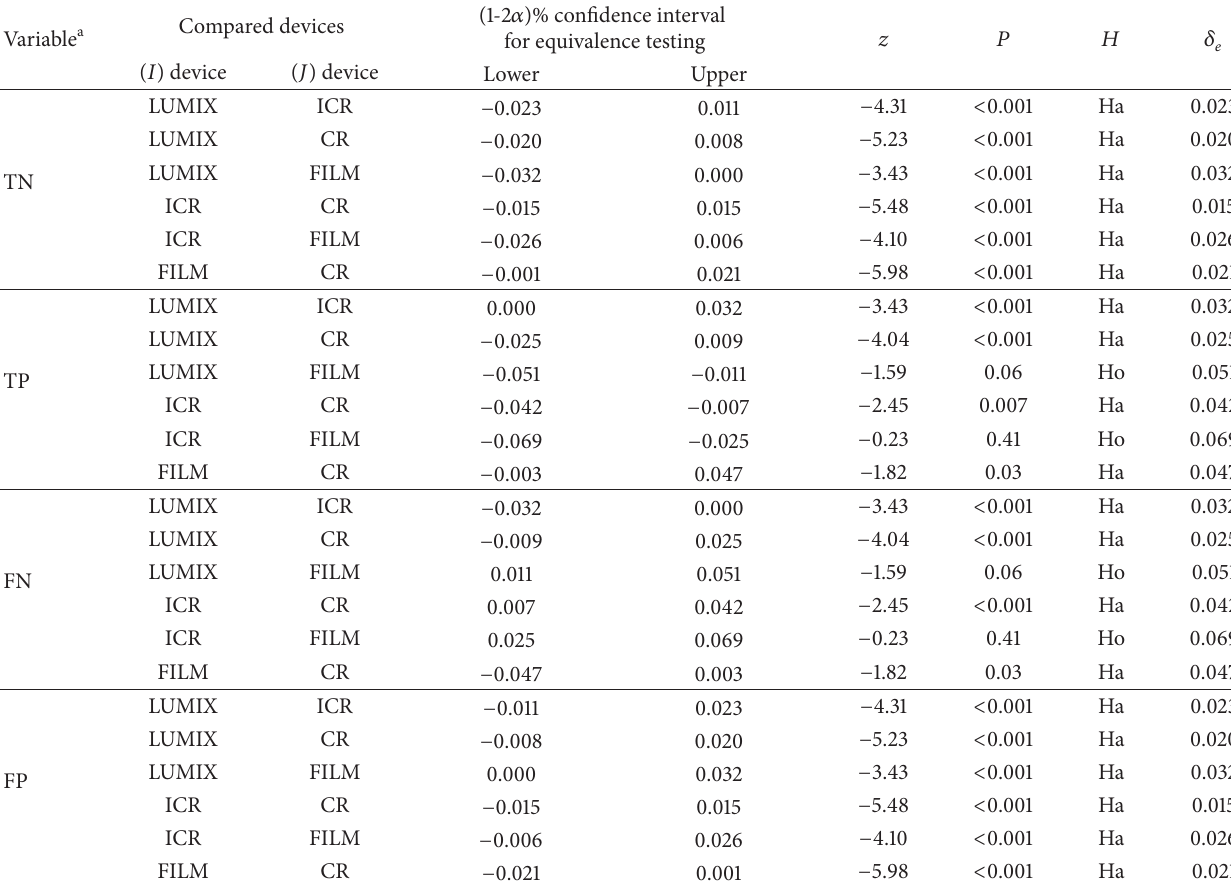
a Each comparison was calculated from 980 observations (70 cases, seven radiologists, and two devices). TN: true negative proportion, TP: true positive proportion, FN: false negative proportion, FP: false positive proportion, SE: standard error of the mean, Ho: null hypothesis, Ha: alternative hypothesis for testing equivalence, 𝛼 : significance of the test (0.05), 𝛿 : difference of the means allowed to achieve equivalence, 𝑧 : test for difference of compared devices, that is, 𝑧 = ( | Difference ( 𝐼 − 𝐽 ) | − 𝛿 )/SE, 𝐻 : retained hypothesis equivalence at 𝛿 level (“Ha” indicates equivalence achieved and “Ho” indicates failing to reject the null hypothes). Ho: | difference ( 𝐼 − 𝐽 ) | − 𝛿 =